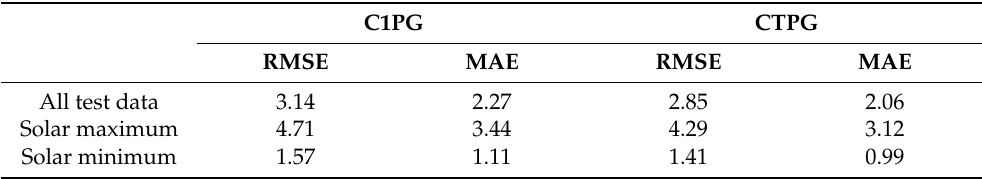
Figure 4. The monthly averaged differences between the forecasting TEC maps (C1PG and CTPG) and IGS TEC maps (CODG) during high and low solar activity periods. Table 2. The annual mean RMSE and MAE values (TECU) between forecasting TEC maps (CTPG and C1PG) and IGS TEC maps (CODG) during high and low solar activity